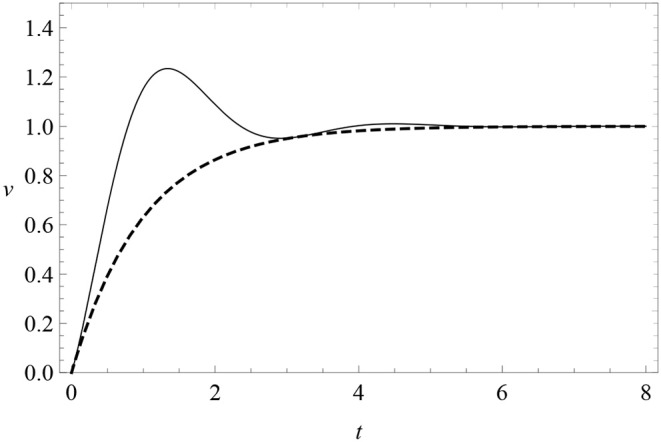
The learning curve (8) (solid) with periodic oscillations with μ = 2 and A = 0, compared with the RW learning curve (4) (dashed). Here λ = 1 = αβ.